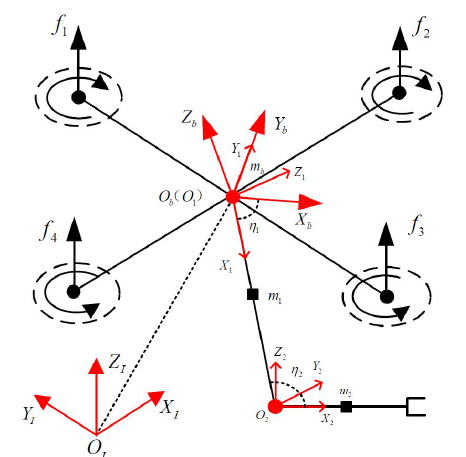
Figure 1. Quadrotor and robotic arm system with coordinate reference